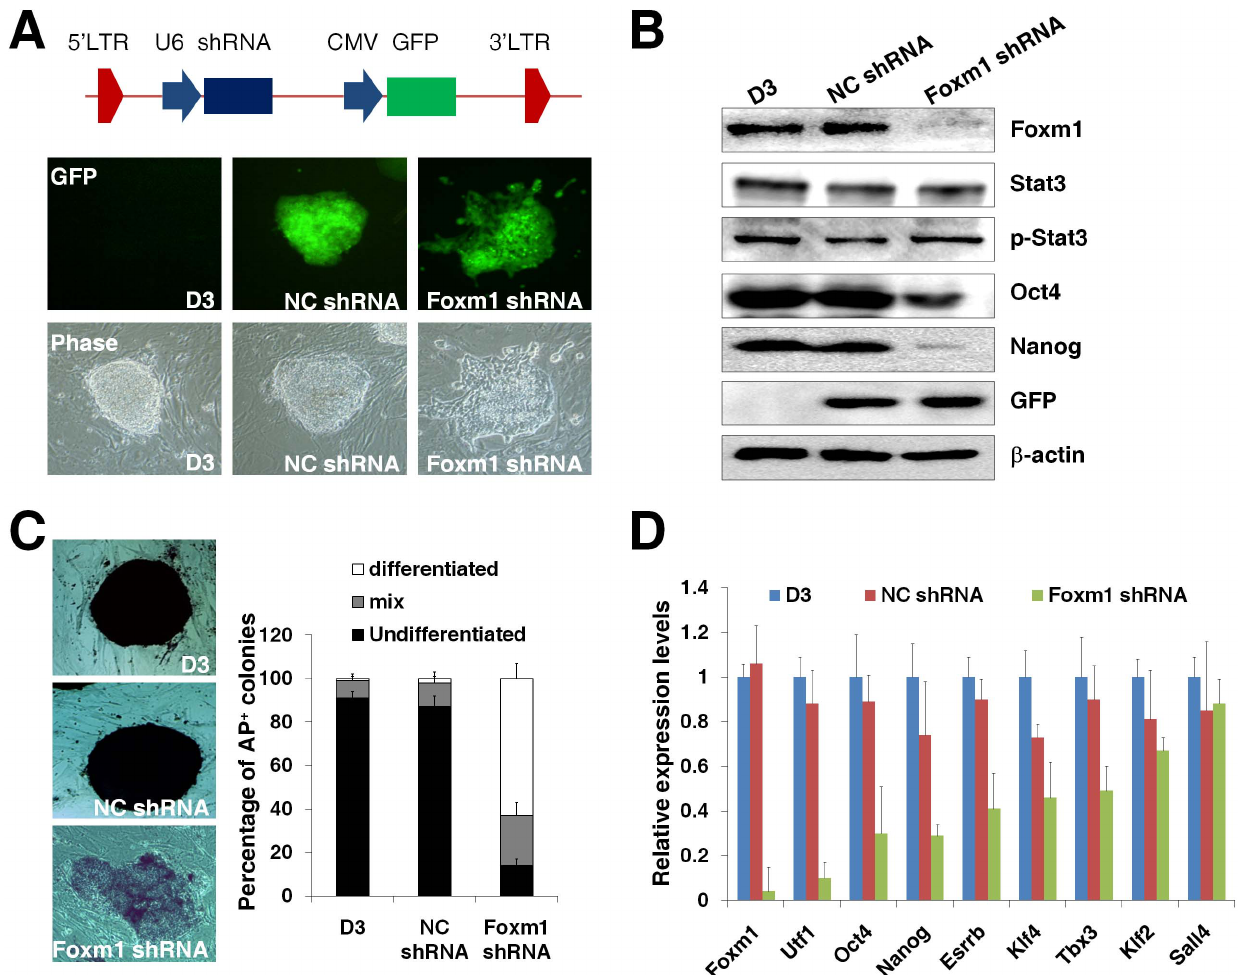
Figure 3. Foxm1 is essential for maintaining the pluripotency of mESCs. (A) The knockdown of Foxm1 expression resulted in the loss of the typical mouse ES cell morphology in D3 ES cells. A lentiviral vector expressing Foxm1-specific shRNA or a control shRNA was produced to infect D3 ES cells for two hours. The lentivirus-infected D3 ES cells were then cultured for one week with the standard ES cell culture condition. Pictures were taken at 200 6 magnification using a TE2000 microscope (Nikon). (B) The Foxm1 knockdown resulted in the decreased levels of Oct4 and Nanog in D3 ES cells. Western blot analyses were performed for the expression of Foxm1, Stat3, phosphorylated Stat3 (p-Stat3), Oct4, Nanog, GFP, and b -actin in D3 ES cells, D3 ES cells infected with the control lentivirus (NC shRNA), or D3 ES cells infected with the Foxm1 shRNA lentivirus (Foxm1 shRNA). (C) D3 ES cells infected with the Foxm1 shRNA lentivirus (Foxm1 shRNA) lost the positive alkaline phosphatase staining. The percentage of differentiated, mix, or undifferentiated colonies of D3 ES cells, D3 NC shRNA cells, or D3 Foxm1 shRNA cells was calculated. (D) The effects of Foxm1 knockdown on the mRNA levels of pluripotency-related genes in D3 ES cells. Quantitative RT-PCR analyses were performed for Foxm1, Utf1, Oct4, Nanog, Esrrb, Klf4, Tbx3, Klf2, and Sall4 mRNA levels in D3 ES cells, D3 NC shRNA cells, or D3 Foxm1 shRNA cells. The levels of each transcript in D3 ES cells were set at 1.0. Error bars indicated standard deviation (n=3).